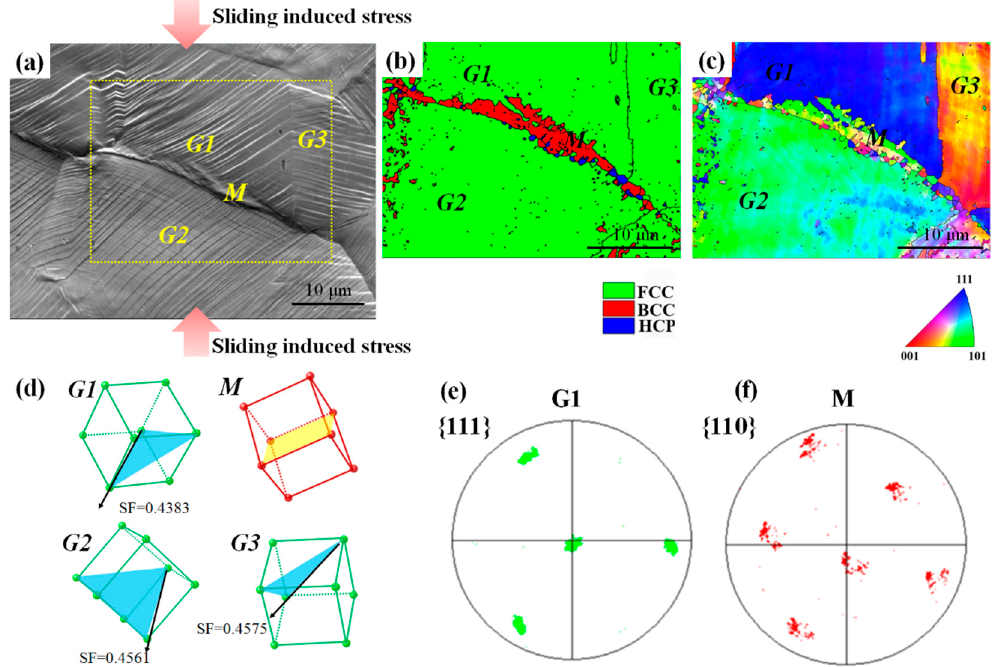
Figure 8. EBSD analysis showing the mechanism of friction-induced martensite transformation: ( a ) SEM image showing the different grains with different slip trace directions, ( b ) IPF map and ( c ) phase map of the area marked by yellow dash line in ( a ). ( d ) Crystal unit cells of the austenite grain G1-G3 and martensite grain M. The slip planes and slip directions with maximum SF in austenite crystals are marked. ( e ) {111} pole figure of the G1 grain. ( f ) {110} pole figure of the M grain.